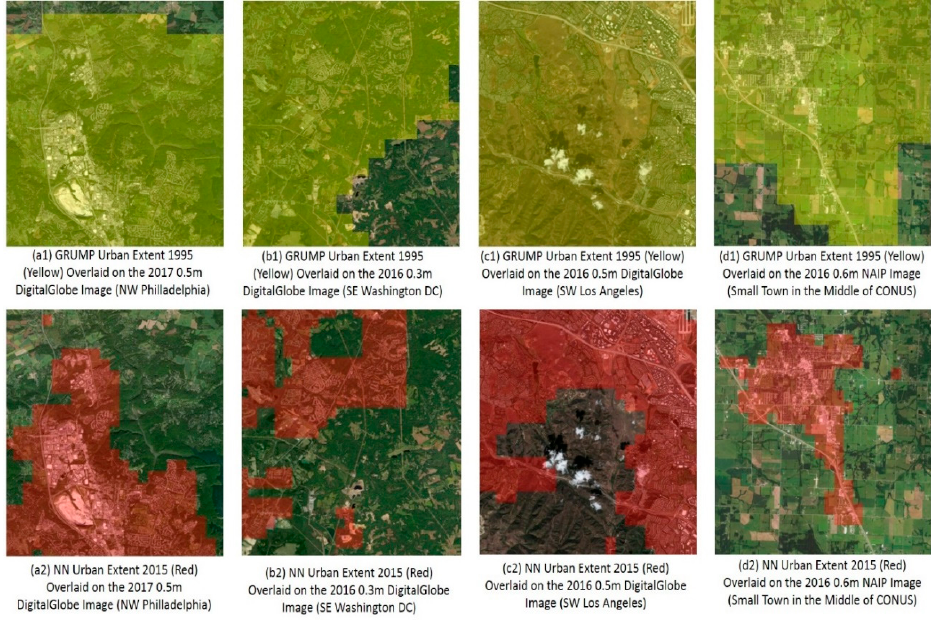
Figure 7. Comparison between 2015 urban extent generated by NN and GRUMP urban extent 1995: ( a1 , b1 , c1 , d1 ) are GRUMP urban extent 1995 (Yellow) while ( a2 , b2 , c2 , d2 ) are NN-based urban extent 2015 (Red).